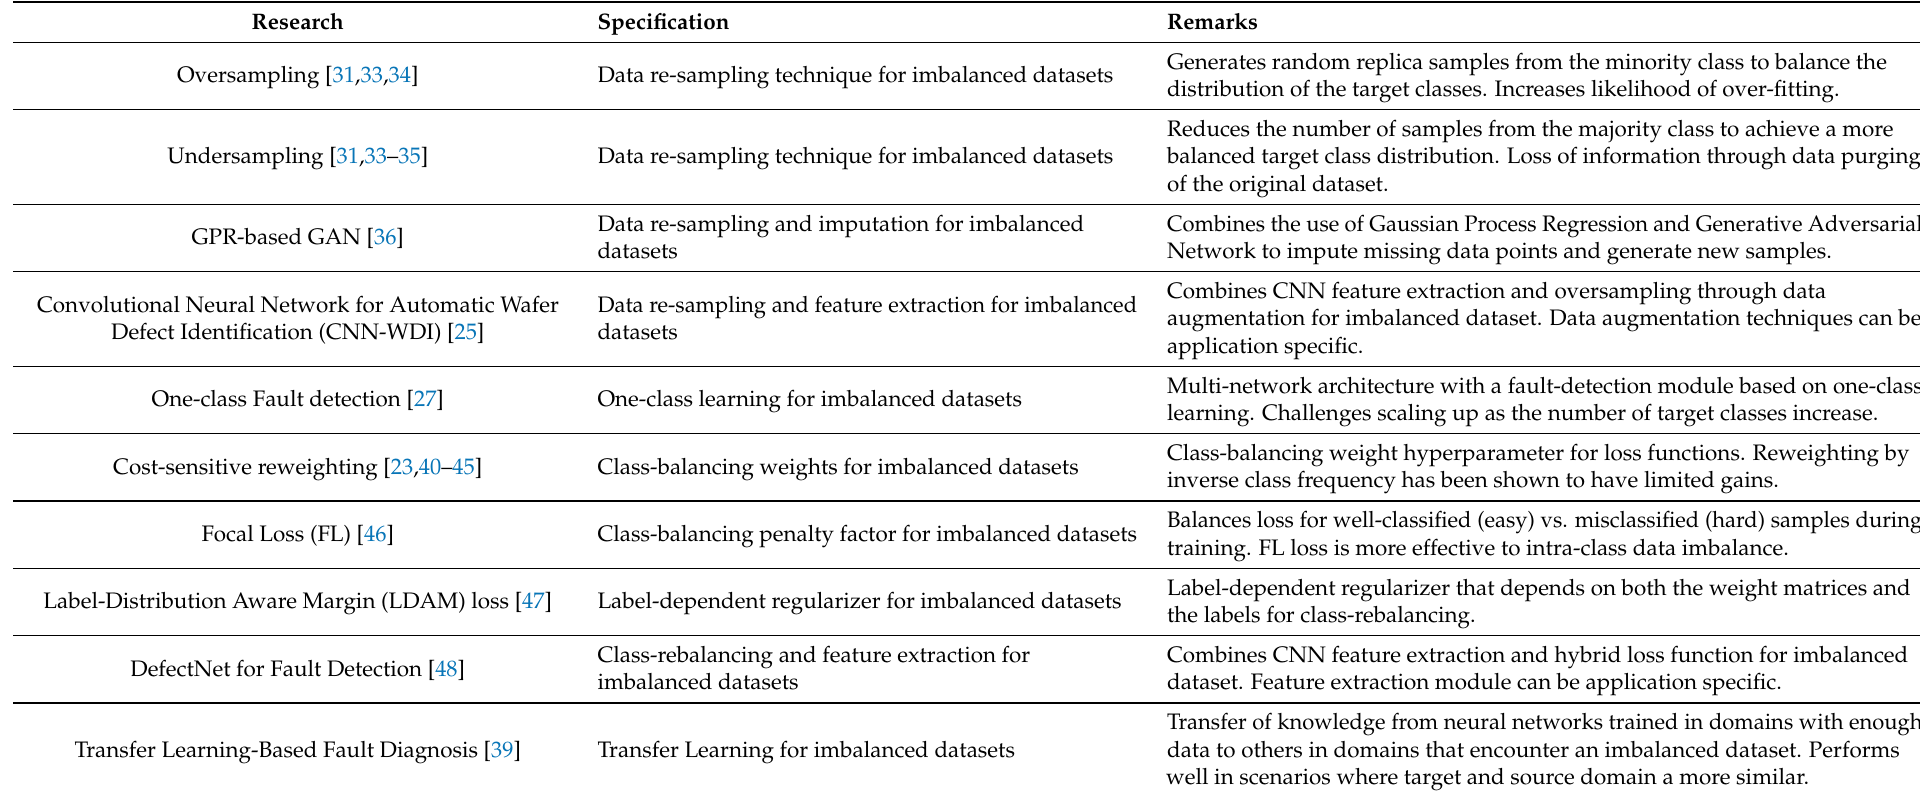
Table 1. Summary of approaches used in tackling imbalanced